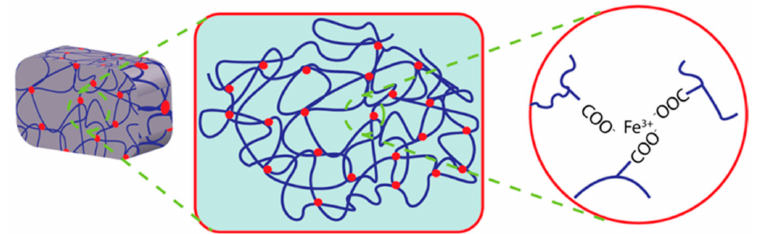
Figure 4. Illustration of Fe ion coordinated self-healing